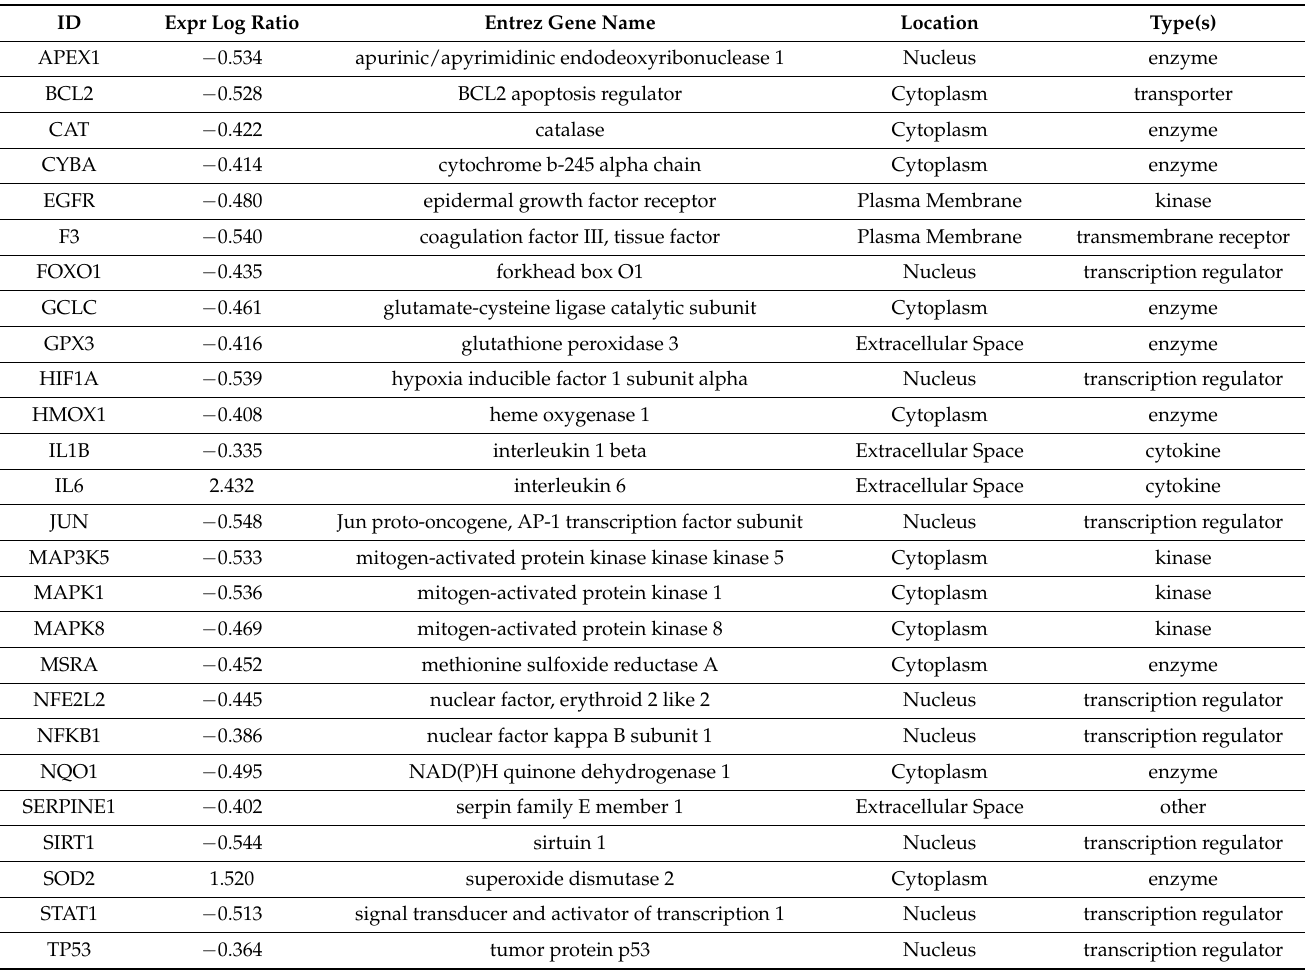
Table 2. List of under- and over-expressed genes following exposure to cigarette smoke in cumulus cells of smokers compared to controls, type(s) and cell